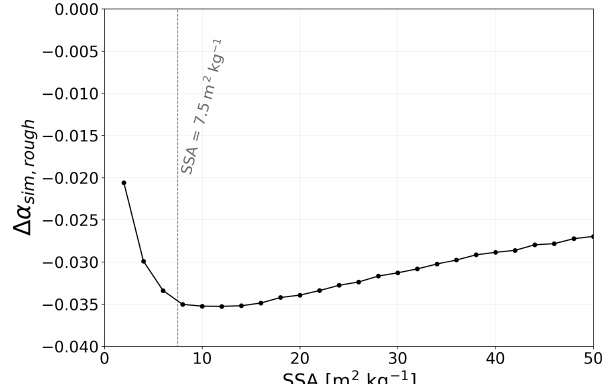
Figure 12. (cid:49)α sim , rough variations as a function of SSA (m 2 kg − 1 ). RSRT simulations are computed with the KZ04 configuration at λ = 1000nm, with the initial conditions of the experiment A η 27% (rectangular shapes, θ s = 63 ◦ , (cid:49)ϕ r = 71 ◦ , without slope; Table 1). The vertical dashed lines indicate the measured SSA (7.4m 2 kg − 1